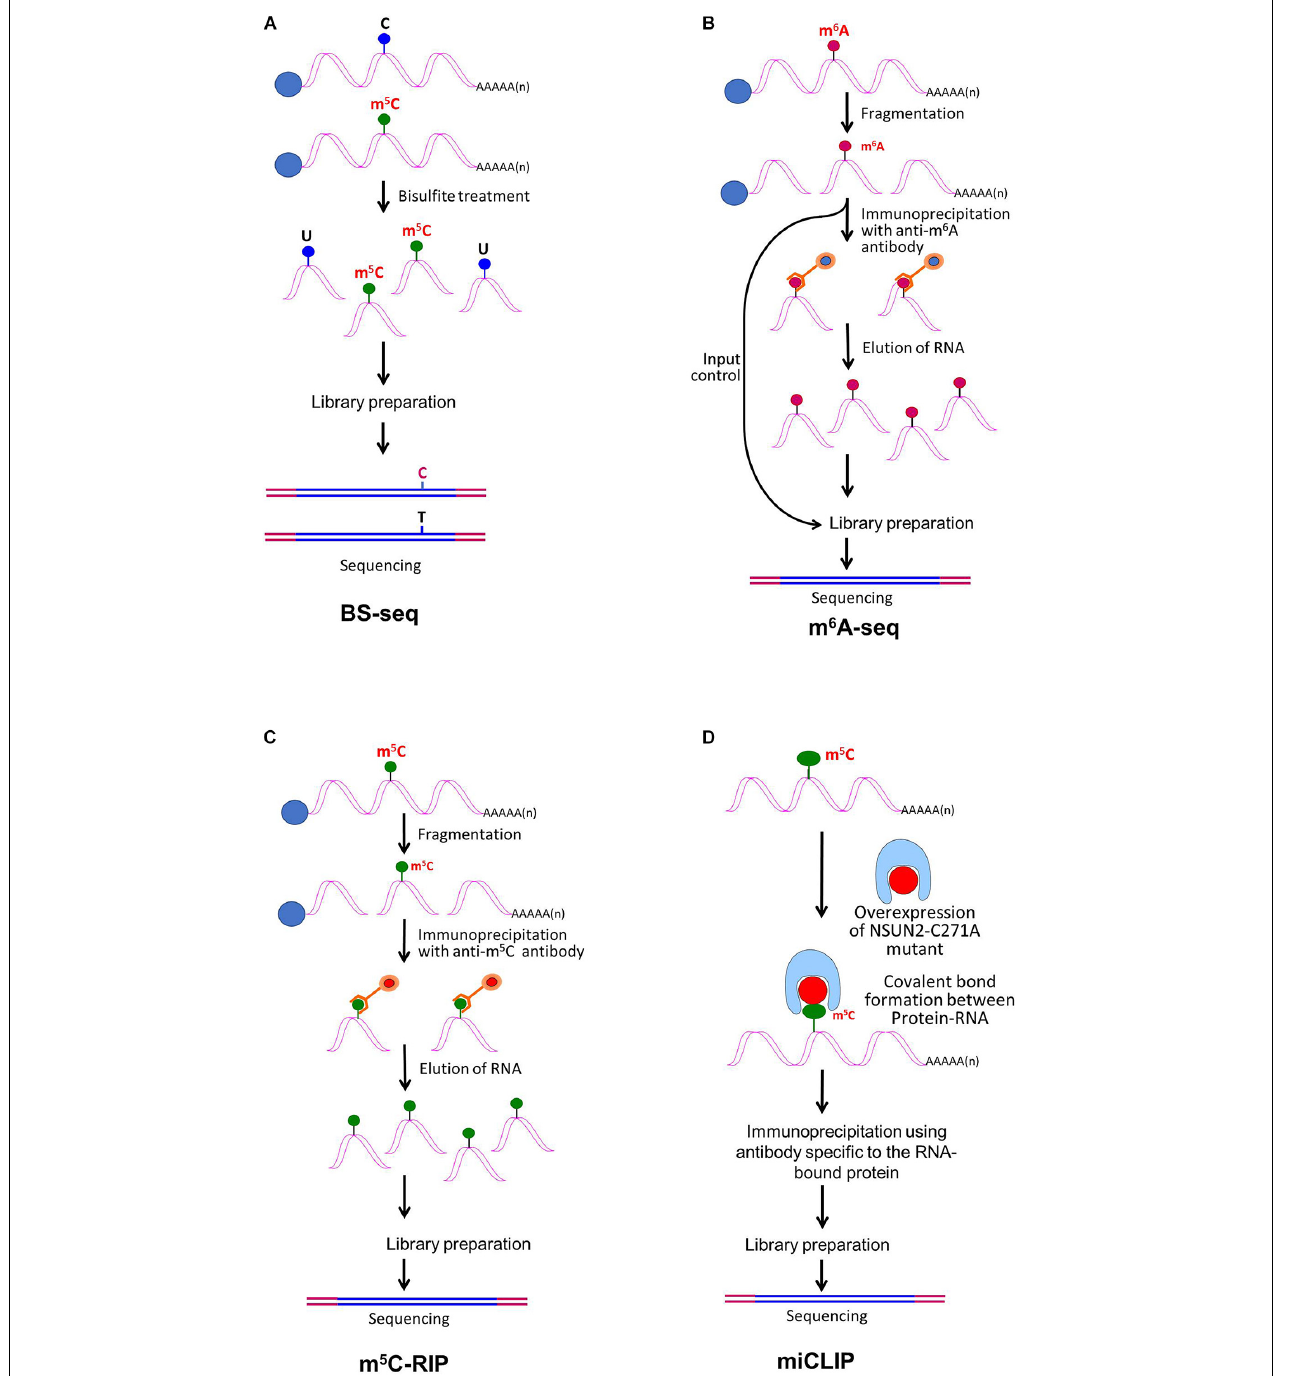
FIGURE 3 | Detection of modified bases in mRNA. (A) Bisulfite sequencing (BS-seq) for the detection of 5-methylcytosine (m 5 C). Purified mRNA is fragmented into small (100–200 nt) fragments, and subjected to bisulfite treatment. Bisulfite treatment causes converts cytosine (C) to uracil (U), but m 5 C remains unchanged. Presence of C is detected by sequencing, wherein it is replaced by T. (B) Purified mRNAs are fragmented into 100–200 nt, followed by immunoprecipitation using anti-m 6 A antibody to enrich the sample with fragments containing the modified base, library preparation, and high-throughput deep-sequencing for detection of m 6 A. (C) Purified mRNAs are fragmented followed by immunoprecipitation using anti-m 5 C antibody of the fragments containing the modified base, library preparation, and sequencing. (D) m 5 C individual-nucleotide-resolution crosslinking and immunoprecipitation (m5C-miCLIP) exploites catalytic activity of cysteine-to-alanine mutation (C271A) mutant of NSUN2 (methyltransferase) which inhibits release of the enzyme from the protein–RNA complex making stable covalent bond between NSun2 and its RNA targets. Antibody specific to the RNA bound protein is used for immunoprecipitation, followed by library preparation and sequencing. This allows detection of low-abundance methylated RNAs without the need of deep sequencing.